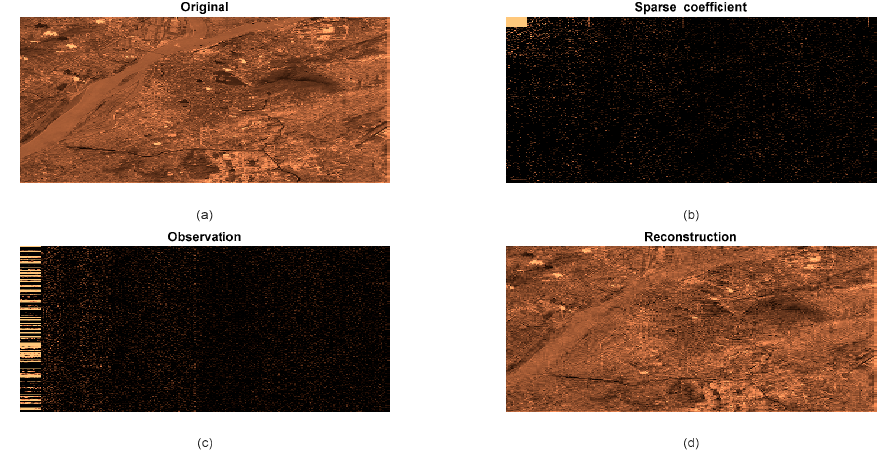
Figure 10. Application in remote sensing image compressing and reconstructing with our proposed method.